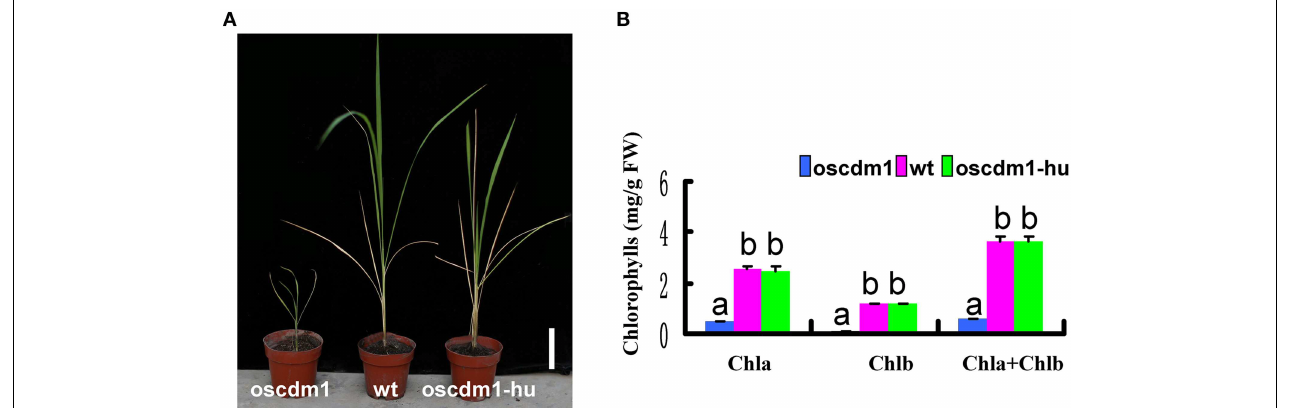
oscdm1 , and oscdm1 -hu plants were measured. The pigment contents of the oscdm1 -hu plants were restored to the wild-type level. The data represent the means ± SD. Bars represent the SDs ( n = 10 ). Chla, chlorophyll a ; Chlb, chlorophyll b . Data were compared by one-way analysis of variance and Duncan’s multiple range test. Different letters (a–b) indicate significant differences (P, 0.05) between